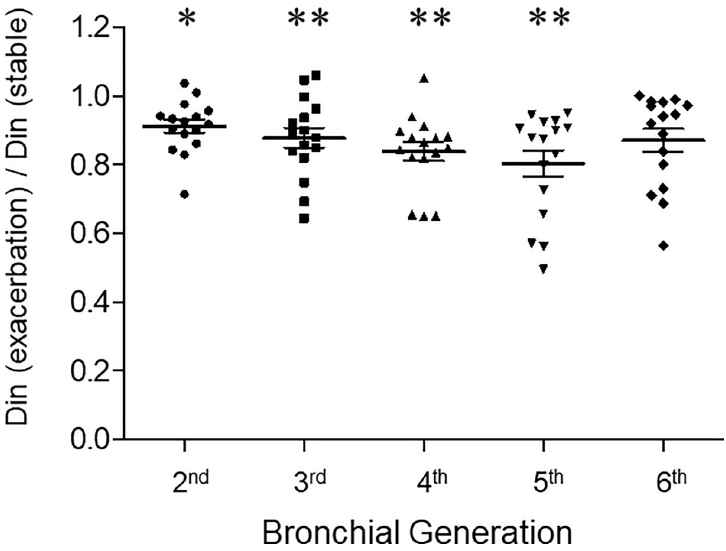
Fig 3. The ratios of Din during asthma exacerbation and in the stable phase observed from the second- (segmental) to sixth-generation bronchi. Din was measured per airway generation in all segments of the lung by HRCT for each subject at suspended end-inspiratory volume using curved MPR software. Each point represents the mean Din ratio of 13 subjects for each segment. � denotes P < 0.05 and �� denotes P < 0.01.